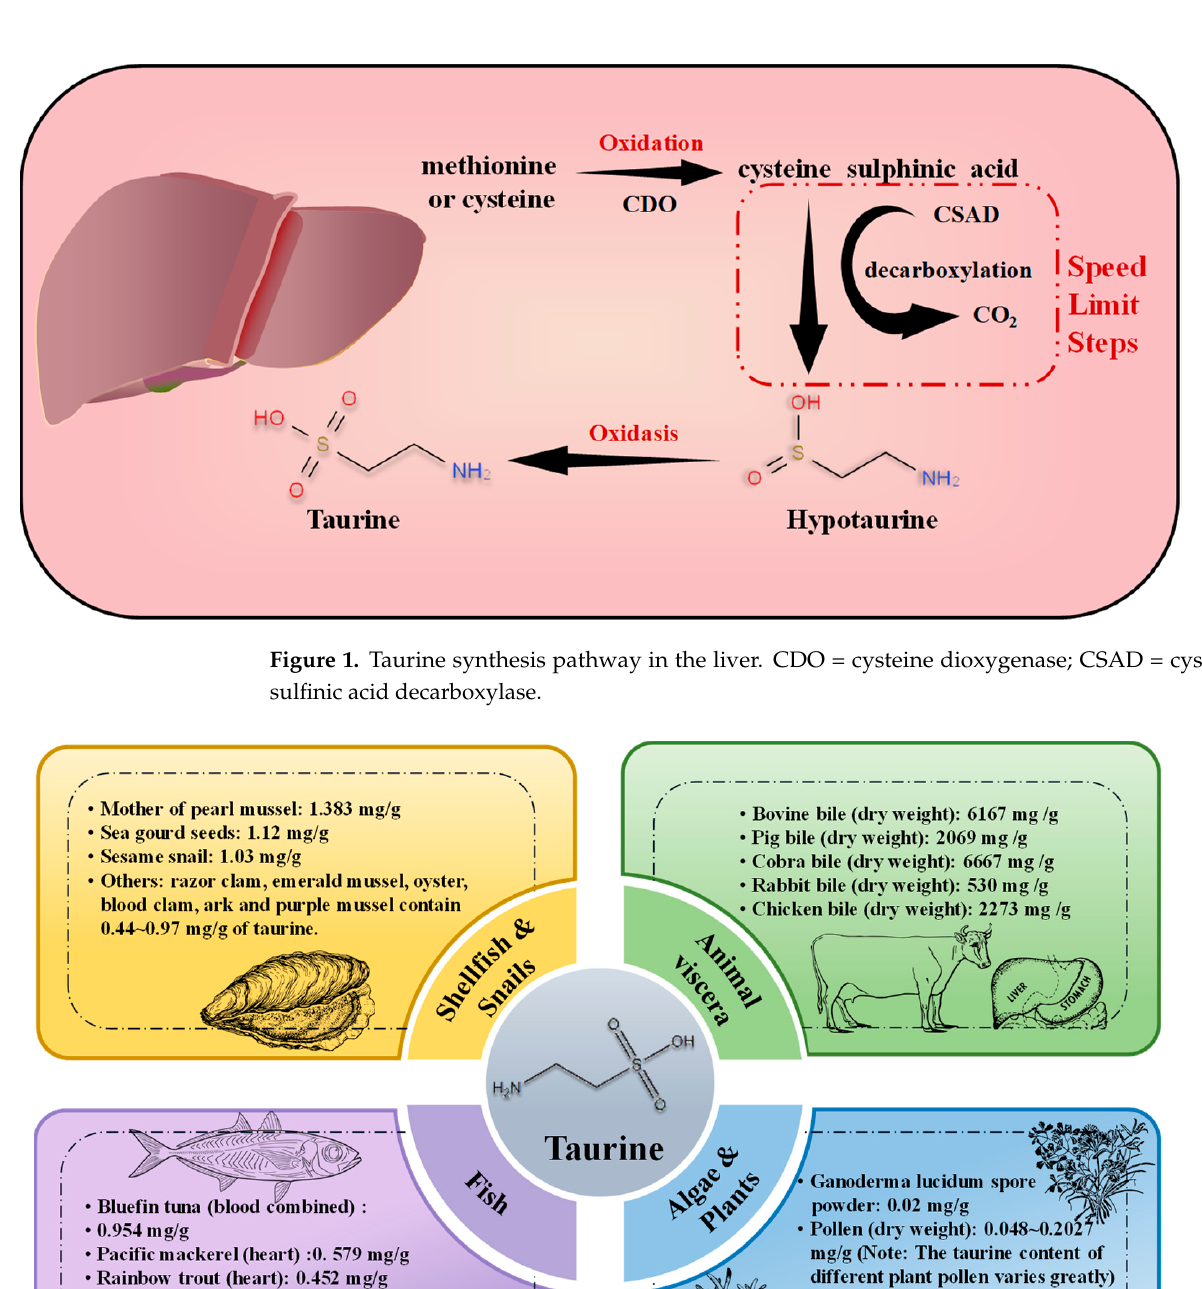
Figure 1. Taurine synthesis pathway in the liver. CDO = cysteine dioxygenase; CSAD = cysteine sulfinic acid decarboxylase.